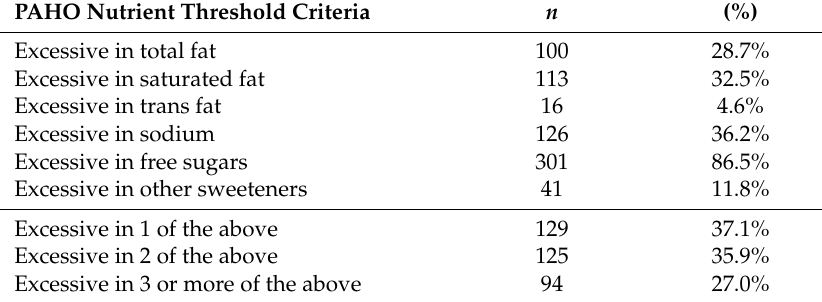
Table 5. Proportion of processed and ultra-processed food products that are not permitted to be marketed to children according to which specific nutrient threshold(s) they exceeded in the PAHO model ( n =